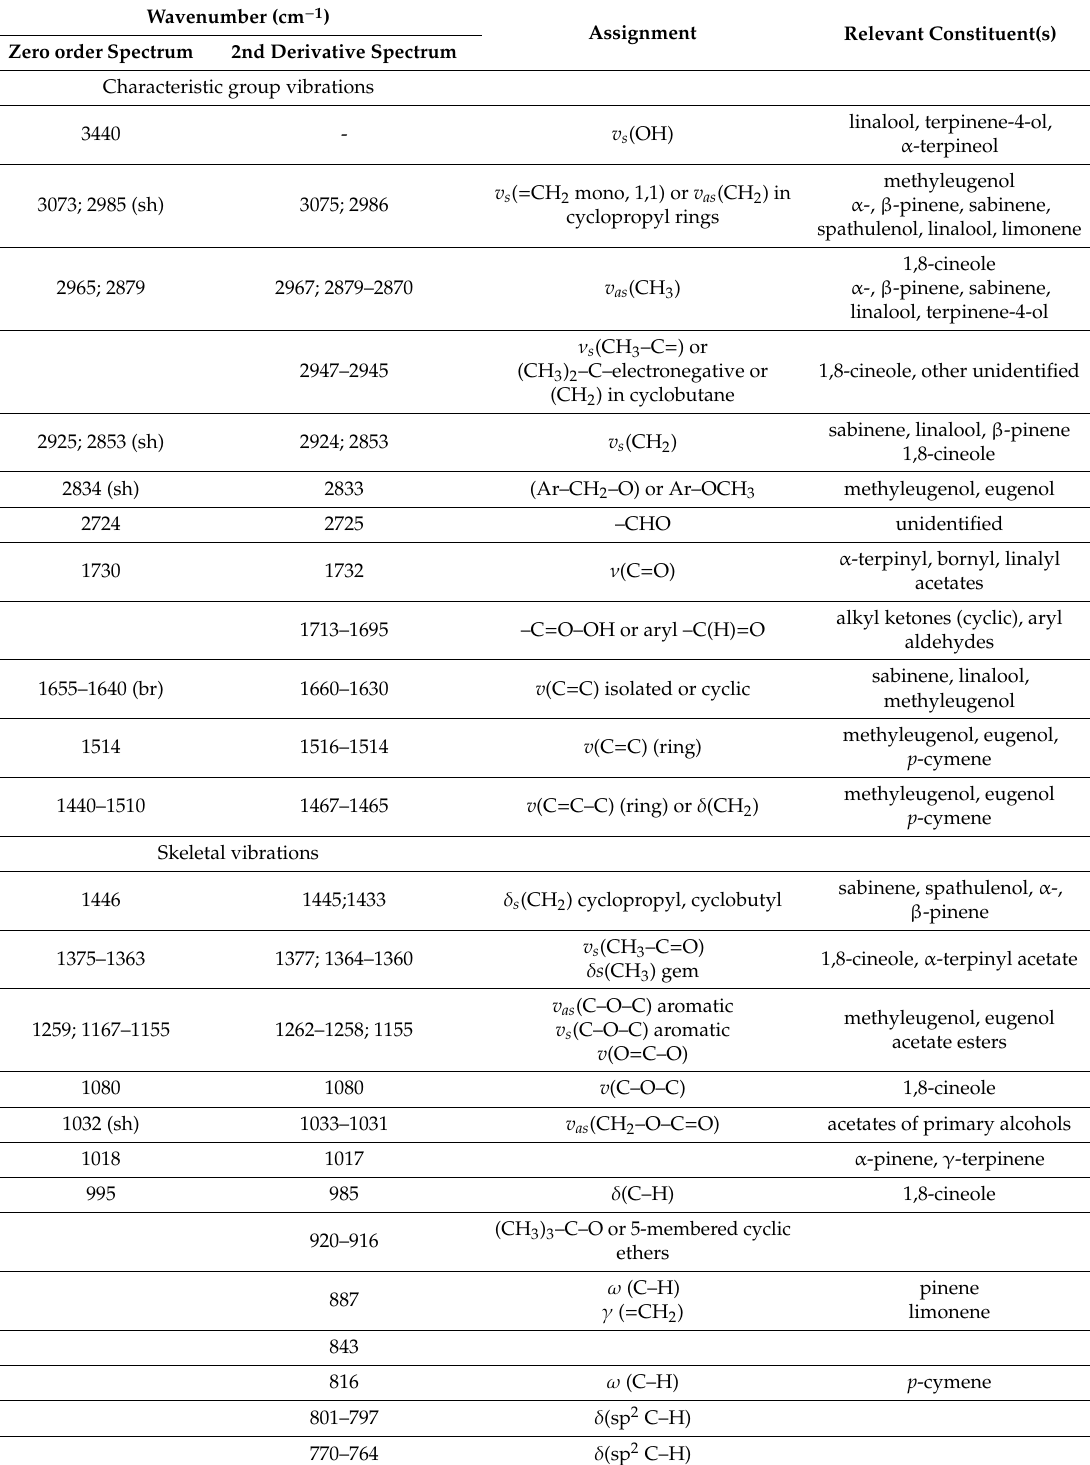
Table 1. Assignment of the most characteristic bands in the FT-IR transmittance spectra of L. nobilis L. EOs based on literature [23–25] and spectra of reference